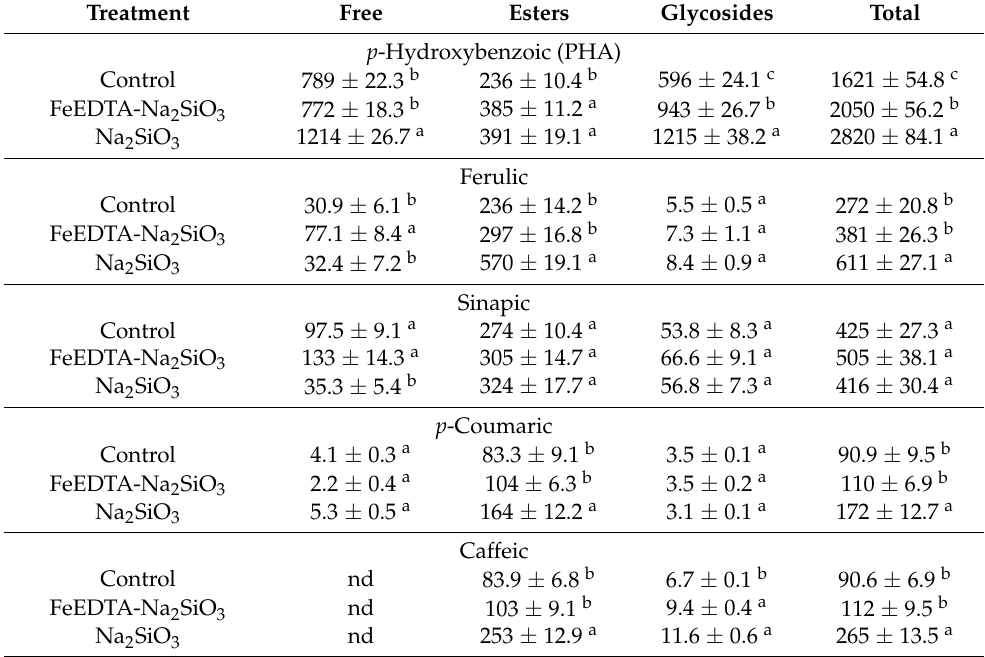
Table 2. The content ( µ g/g DW) of phenolic acids (free, released from ester and O-glycoside forms, and in total) in broccoli sprouts ( µ g/g DW) treated with elicitors during growth.